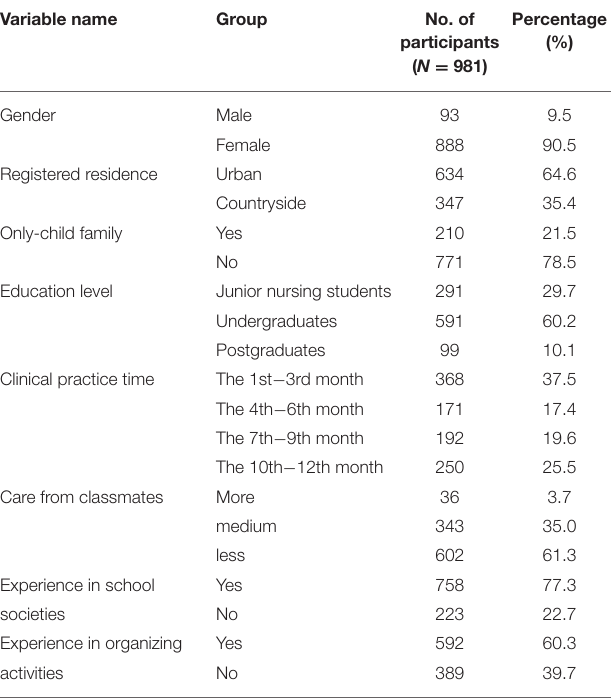
TABLE 1 | Characteristics of nursing students, Changsha, Hunan, China ( N =